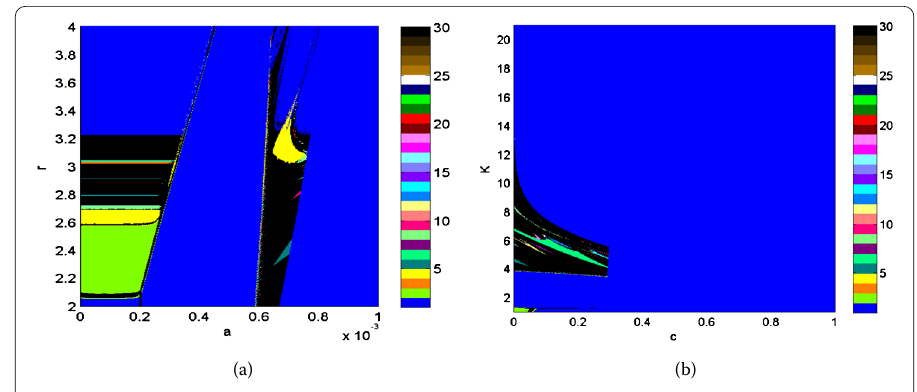
Figure 4 Numerical simulations of equation (1.2) with two parameters. (a) The a × r parameter plane of system (1.2); (b) The phase diagram for c × k